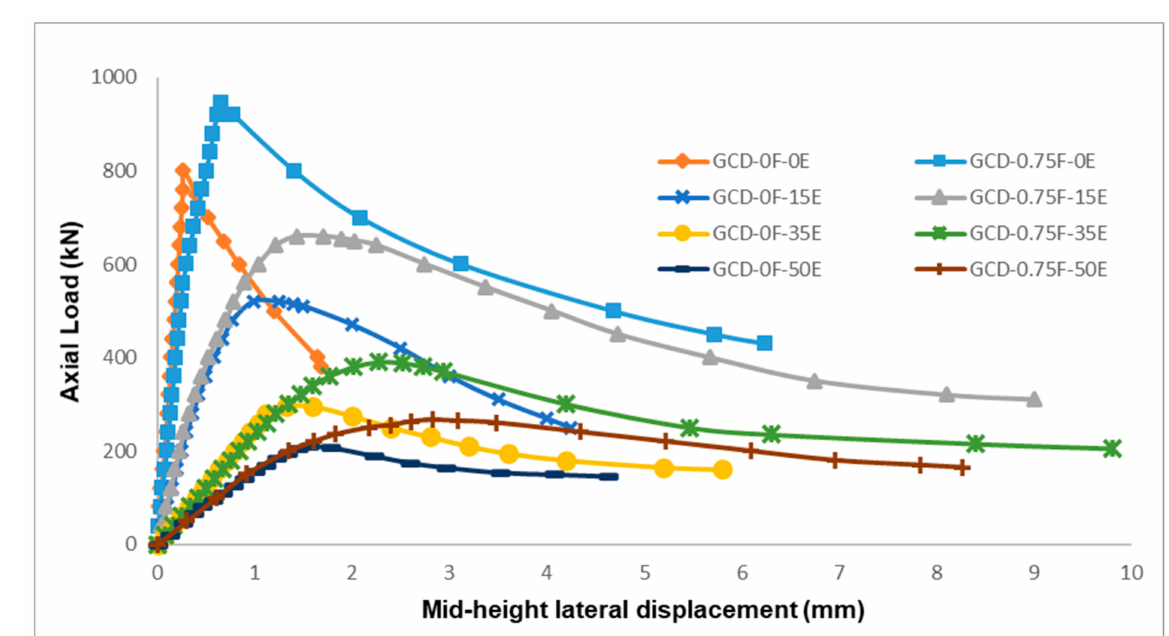
Figure 14. The axial load–lateral displacement behavior of GCD